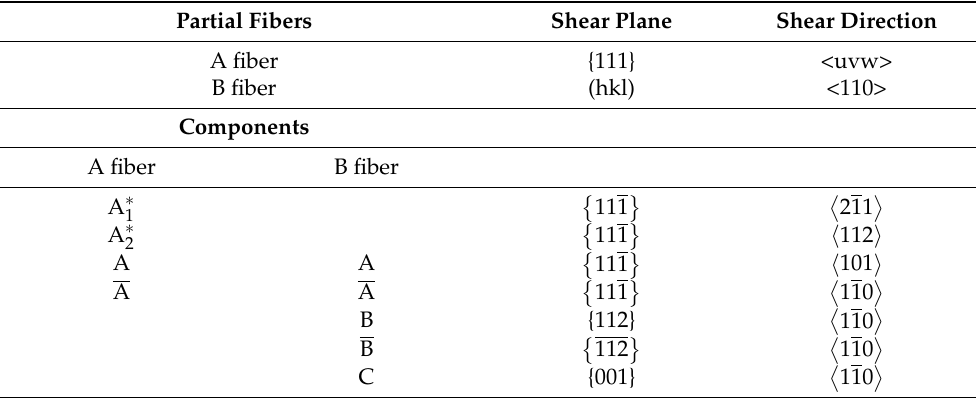
Figure 10. (111) and (110) pole figures of commercial pure Cu after processing through 4-Bc_RT with the ideal simple shear texture components superimposed (for interpretation of the references to color in this figure legend, the reader is referred to the web version of the article).